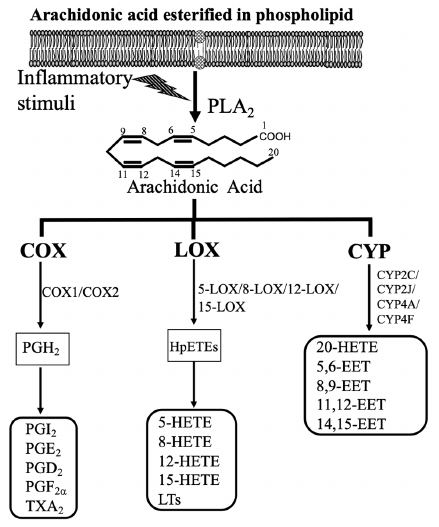
Figure 1. Bioactive eicosanoids derived from arachidonic acid (AA) cascade. After trigging by inflammatory conditions such as the presence of cytokines and growth factors, AA-containing phospholipids are hydrolyzed by phospholipase A2 (PLA2), resulting in the release of free AA. AA can be further metabolized by three pathways, i.e., the cyclooxygenase (COX), lipoxygenase (LOX), and cytochrome P450 (CYP) pathways. AA cascade generates prostaglandins (PGs), thromboxane A2 (TXA2), and a series of hydroxyeicosatetraenoic acids (HETEs), leukotrienes (LTs), and epoxyeicosatrienoic acids